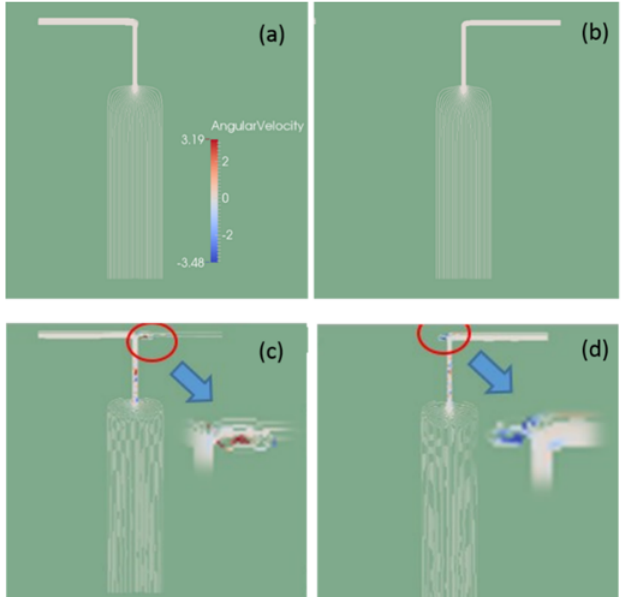
Figure 7. Streamlines and angular velocity in the Newtonian fluid case ( a , c ) and viscoelastic fluid case ( b , d ) under modulated pressure at the inlet I 1 and constant pressure at the inlet I 2 .